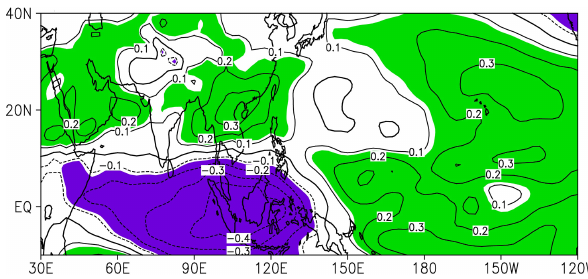
Figure 9. Regressions of the convergence at 300hPa onto the si- multaneous NAOI. Color shading indicates significance at the 0.05 level.